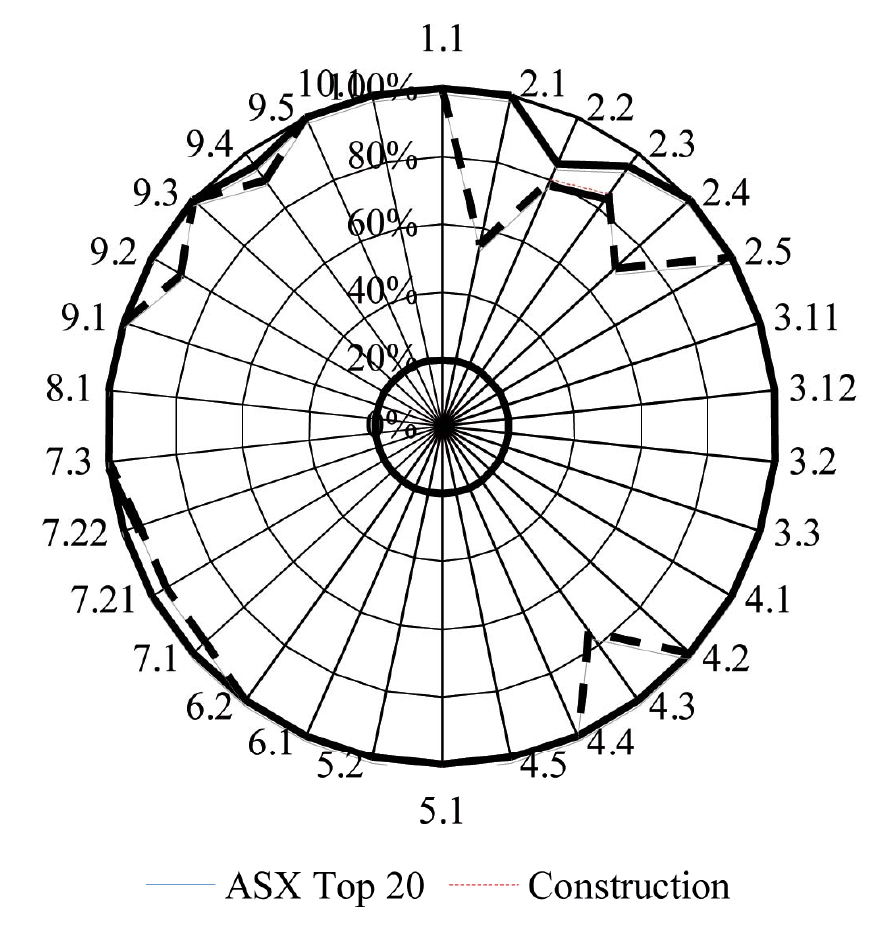
Figure 1: Summary of ASX compliance comparison